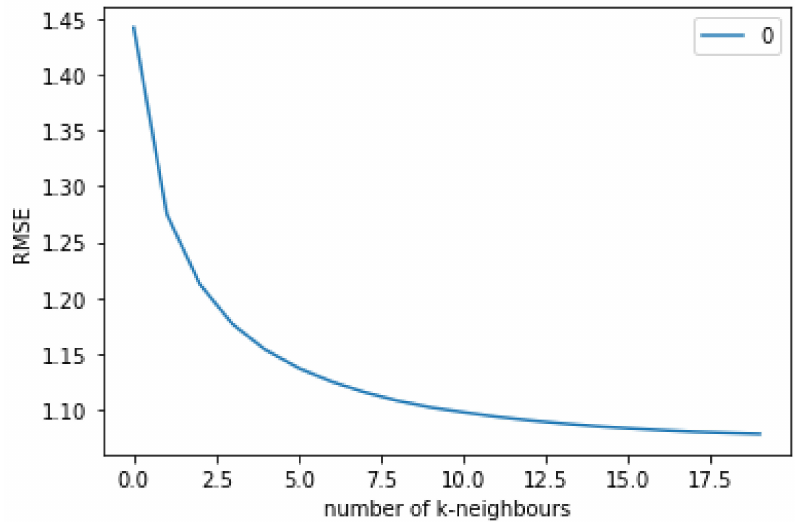
Figure 6. Elbow Curve for kNN